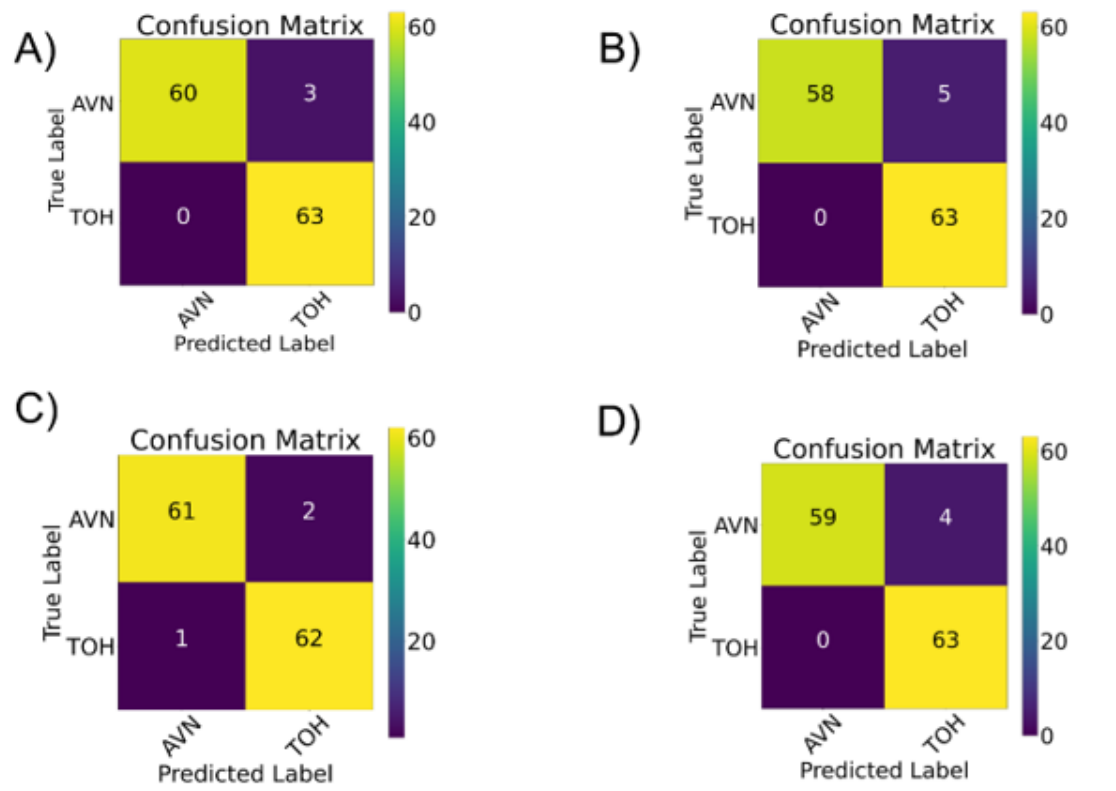
Figure 3. Confusion matrices for the ensemble CNN decision ( A ), for VGG ‐ 16 ( B ), InceptionV3 ( C ) and Inception ‐ ResNetV2 ( D ). TOH: transient osteoporosis of the hip; AVN: avascular necrosis of the femoral head. Table 1. Performance metrics of individual convolutional neural networks and the respective net ‐ work ensemble.